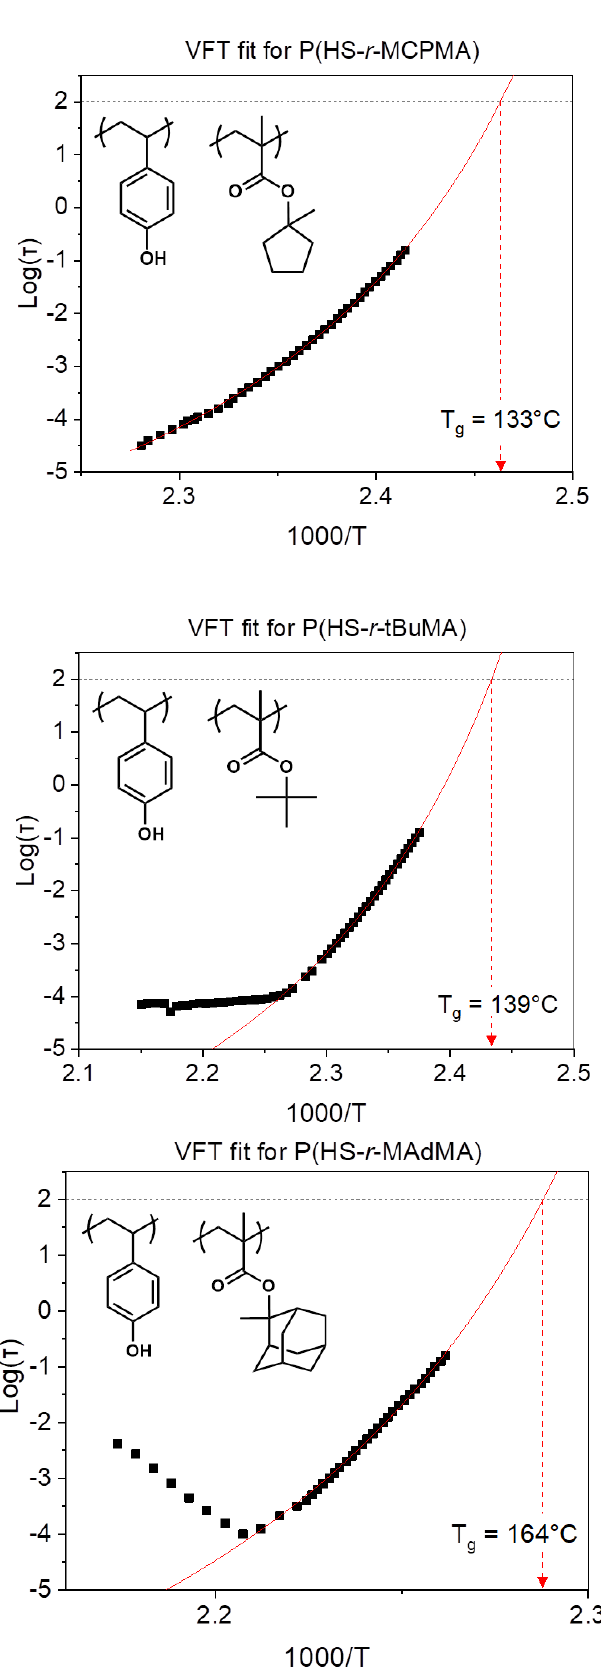
Figure 3. Logarithmic structural relaxation time versus the inverse of temperature plots for the different 30 nm thin film polymer samples.